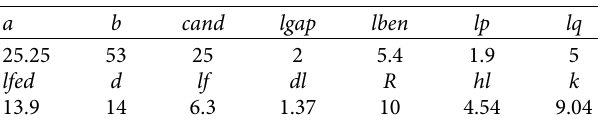
Figure 8: The geometry of antenna 4 with the taper ACPW-fed slot. Table 4: Parameters of antenna 4